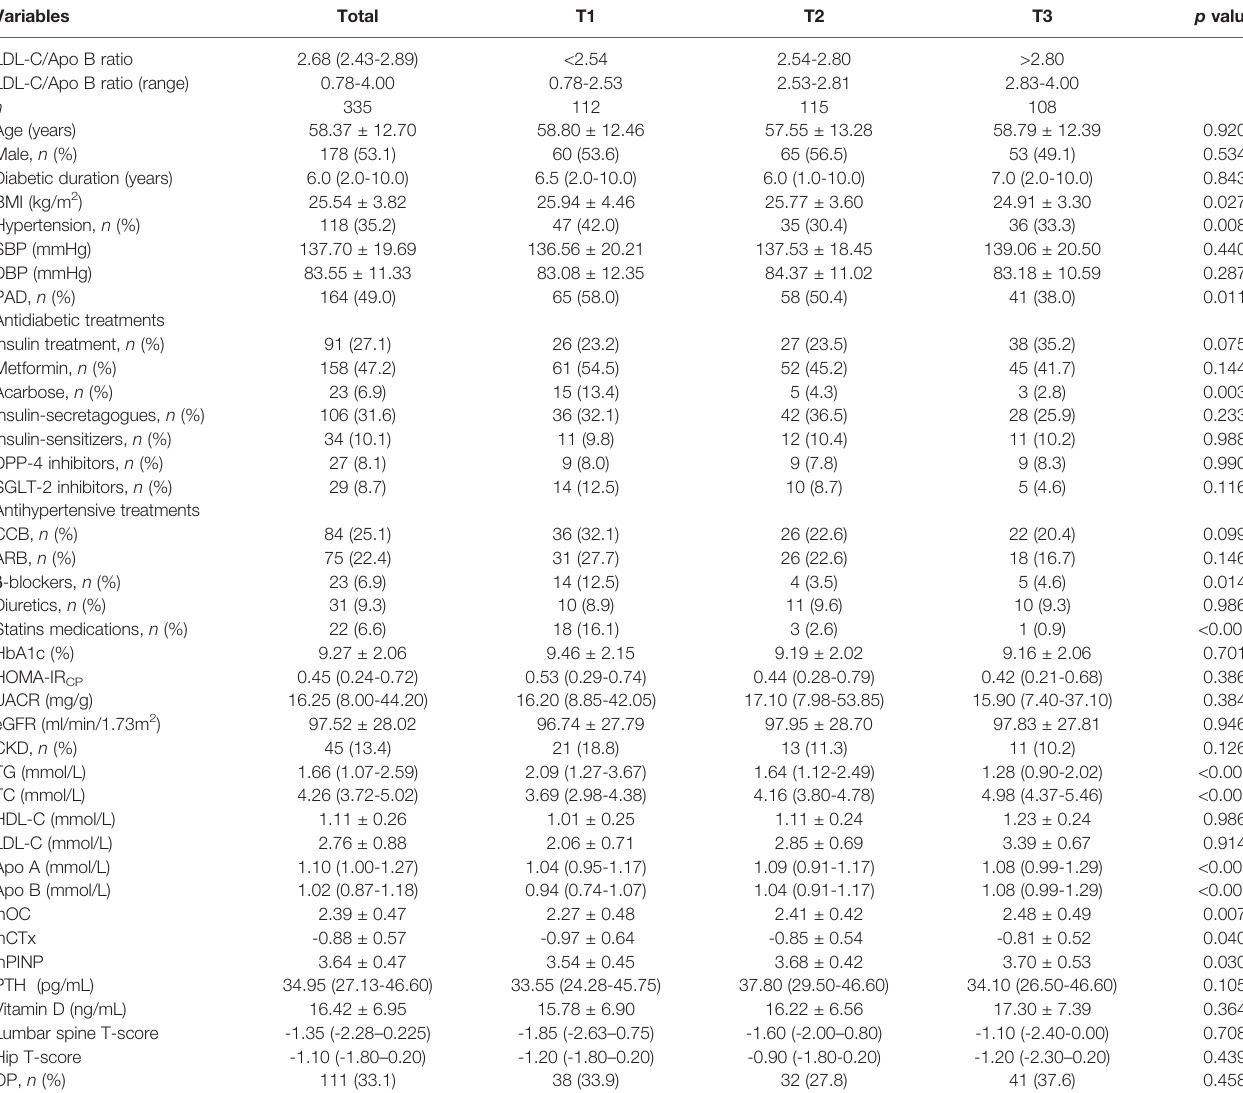
TABLE 1 | Clinical characteristics of the study participants. Variables Total T1 T2 T3 p value LDL-C/Apo B ratio